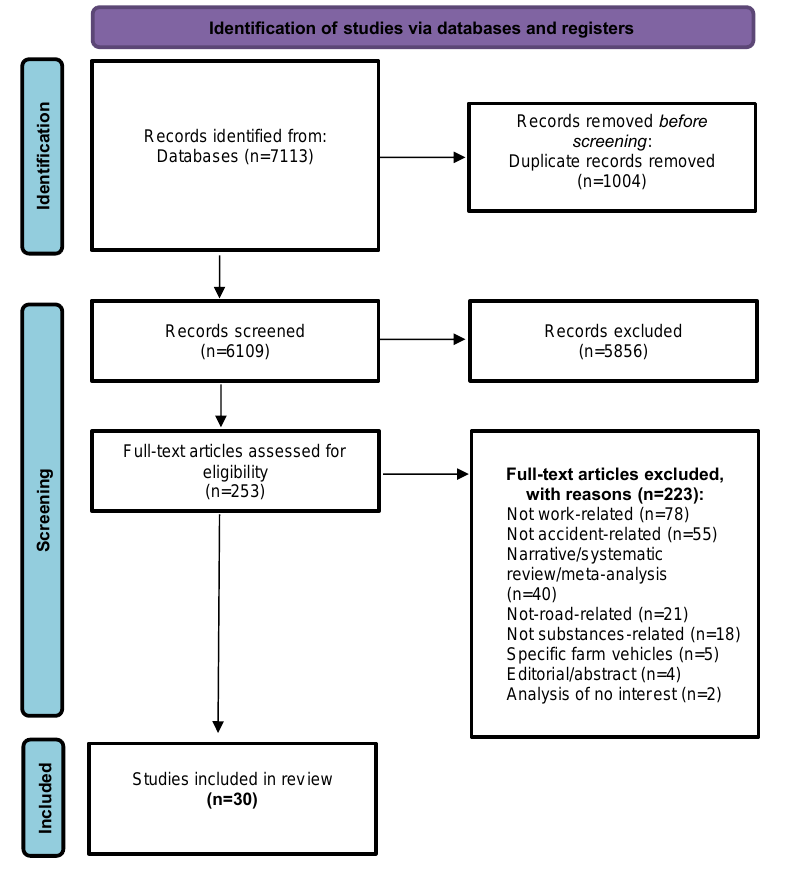
Figure 1. Flow Diagram.